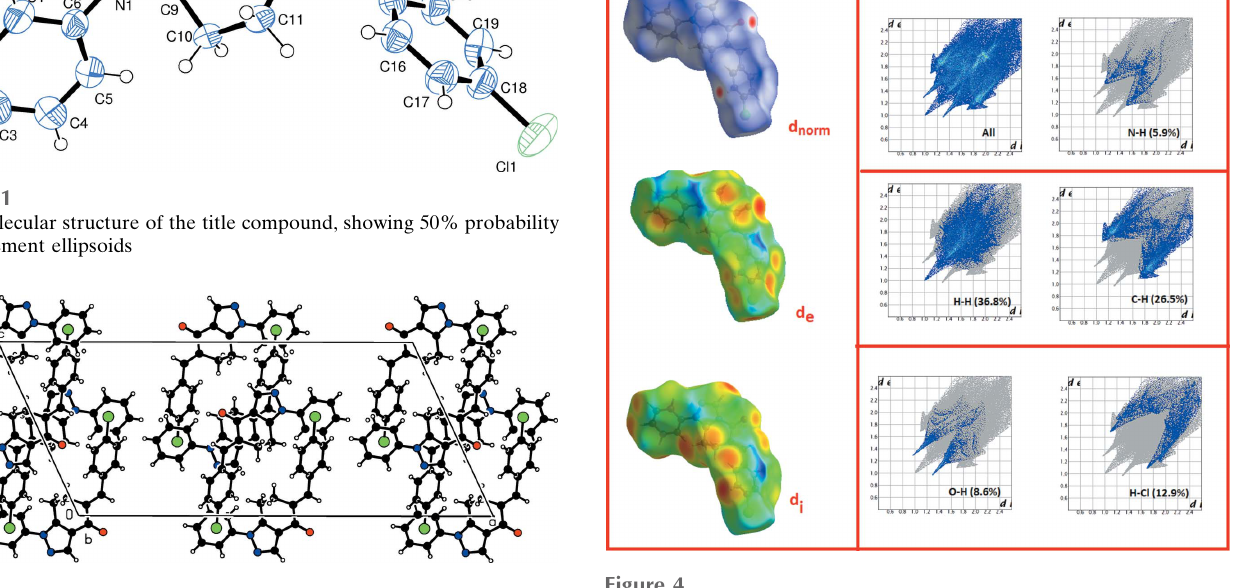
Figure 2 A view of the unit-cell contents viewed in projection down the b -axis.